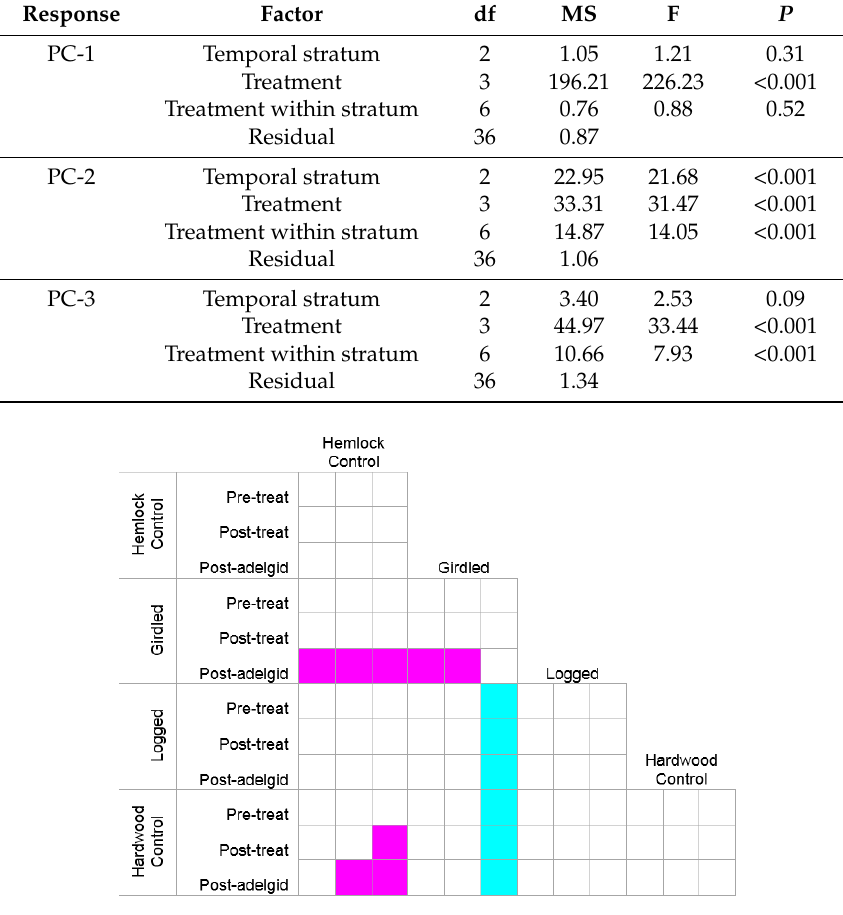
Figure 3. Post-hoc , pair-wise comparisons (Tukey’s Honest Significant Difference Test) of the response (principal axis 2) to canopy manipulation treatments (hemlock control, girdled, logged, and hardwood control) repeated within temporal strata (pre-manipulation (2003–2004); post-manipulation but prior to adelgid colonization (2005–2009); and after the adelgid had colonized the plots (2010–2014)). For each pair-wise comparison, differences between PC-2 of a given row and PC-2 of a given column are significantly greater than (magenta) or less than (blue) zero ( p ≤ 0.05).